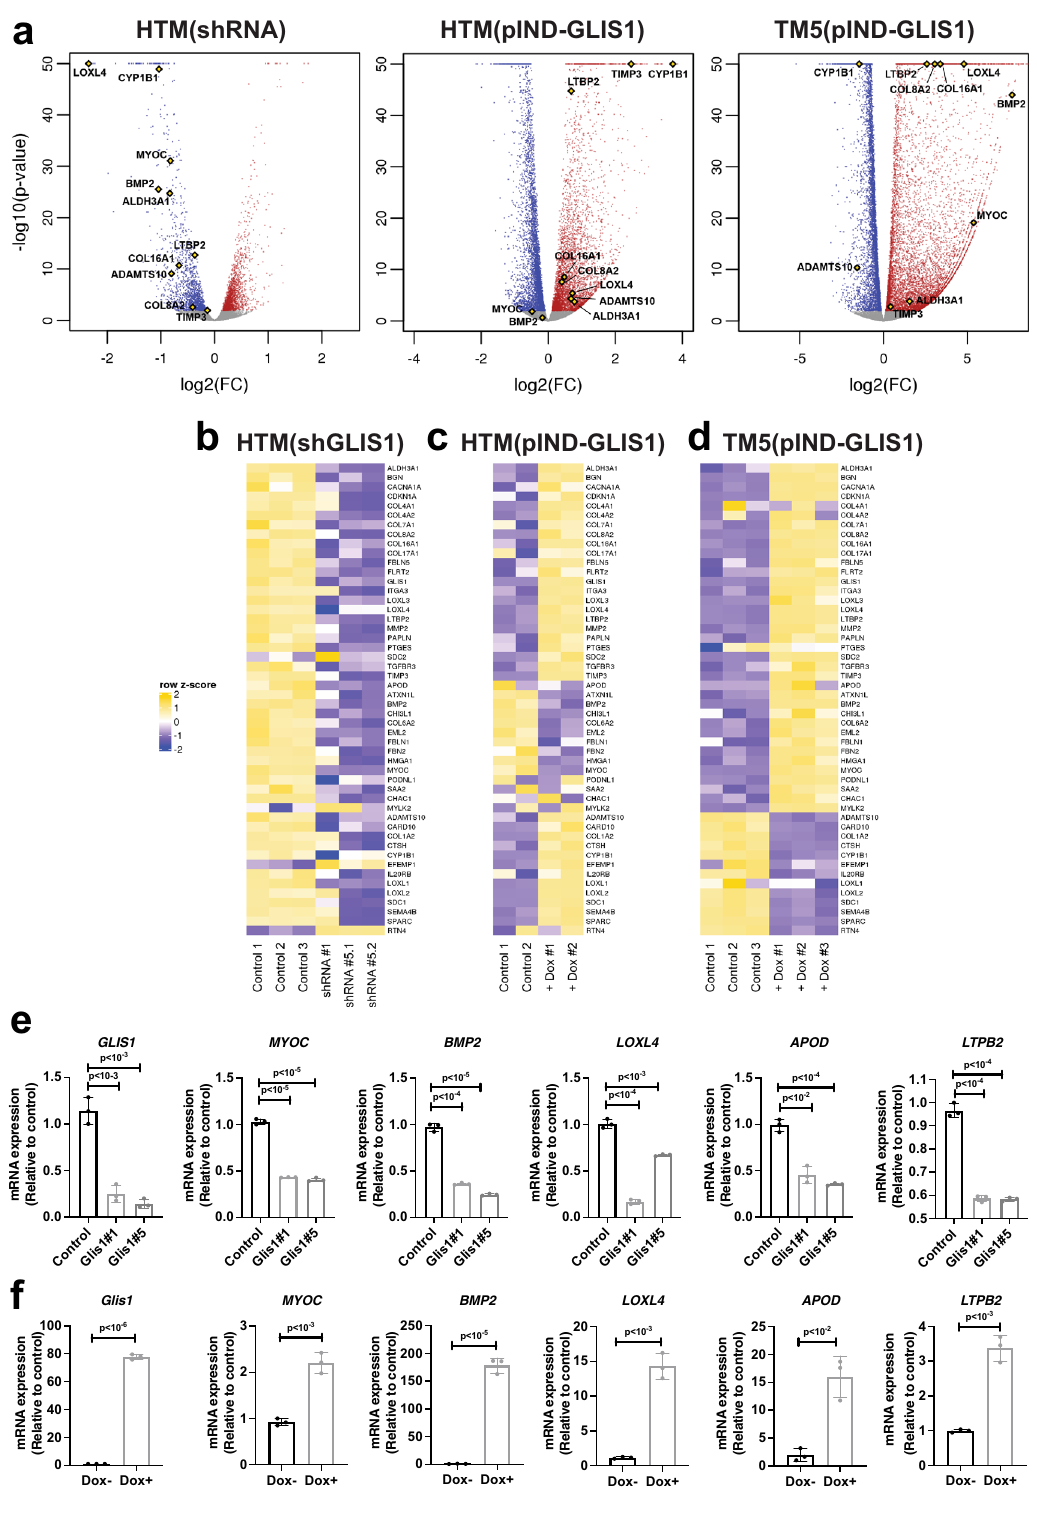
The association of rs941125 with POAG has recently been con- fi rmed and replicated in additional cohorts at a genome-wide level of signi fi cance ( p = 2.01 × 10 − 11 , meta-analysis) 58 . Further- more, rs941125 is signi fi cantly associated with variation in GLIS1 gene expression in several tissues in GTEx (https://gtexportal.org/ home/snp/rs941125). Together, these fi ndings support a role for GLIS1 in glaucoma pathogenesis in humans. NATURE COMMUNICATIONS| (2021) 12:4877